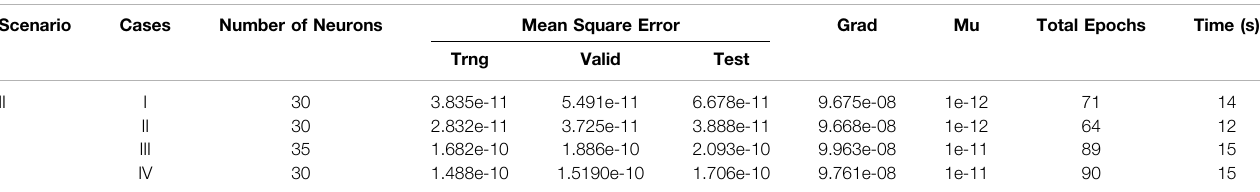
TABLE 5 | Numerical performance indicators for scenario II.